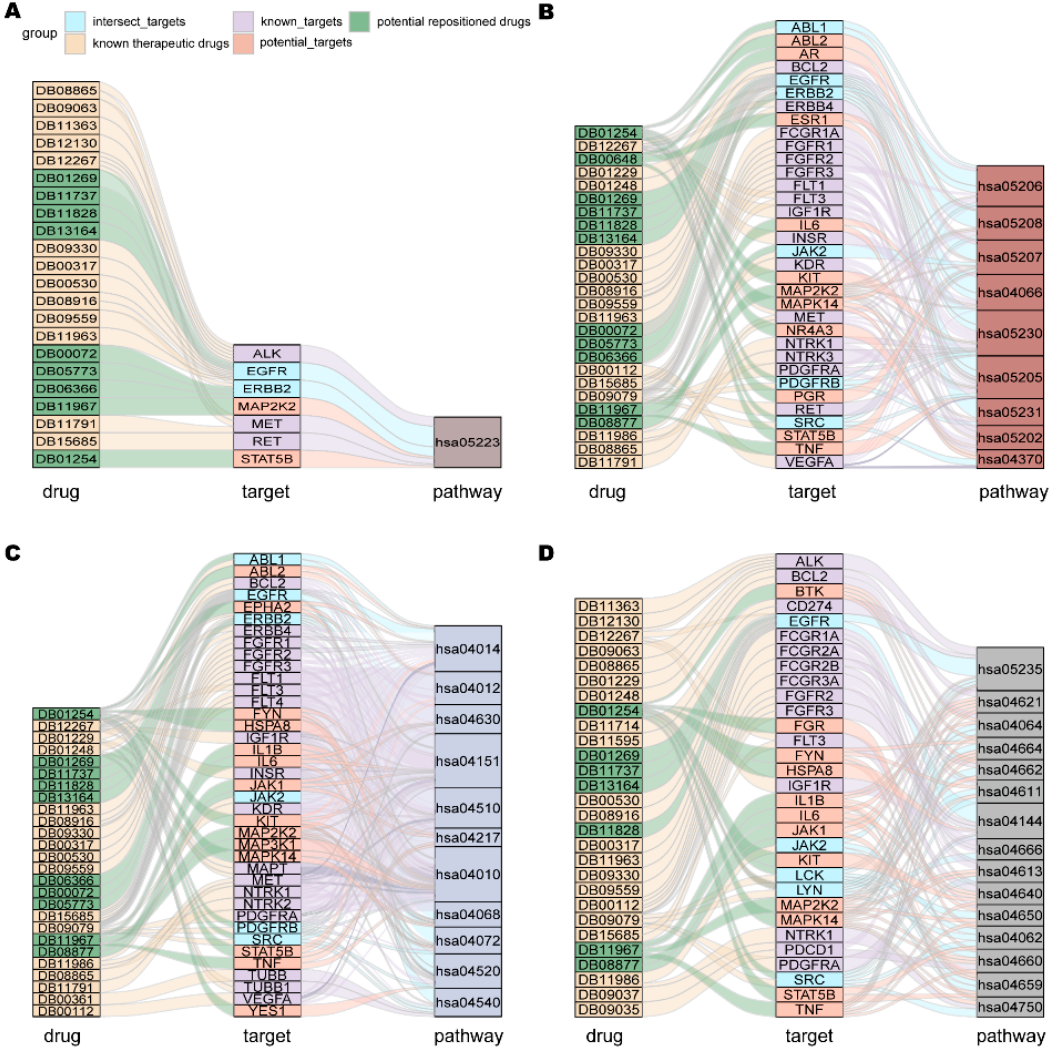
Figure 6. KEGG enrichment analysis. ( A ) NSCLC pathway. ( B ) Cancer progression-related pathway. ( C ) Cell process-related pathway. ( D ) Immune-related pathway. The different types of pathways are marked with different colors.